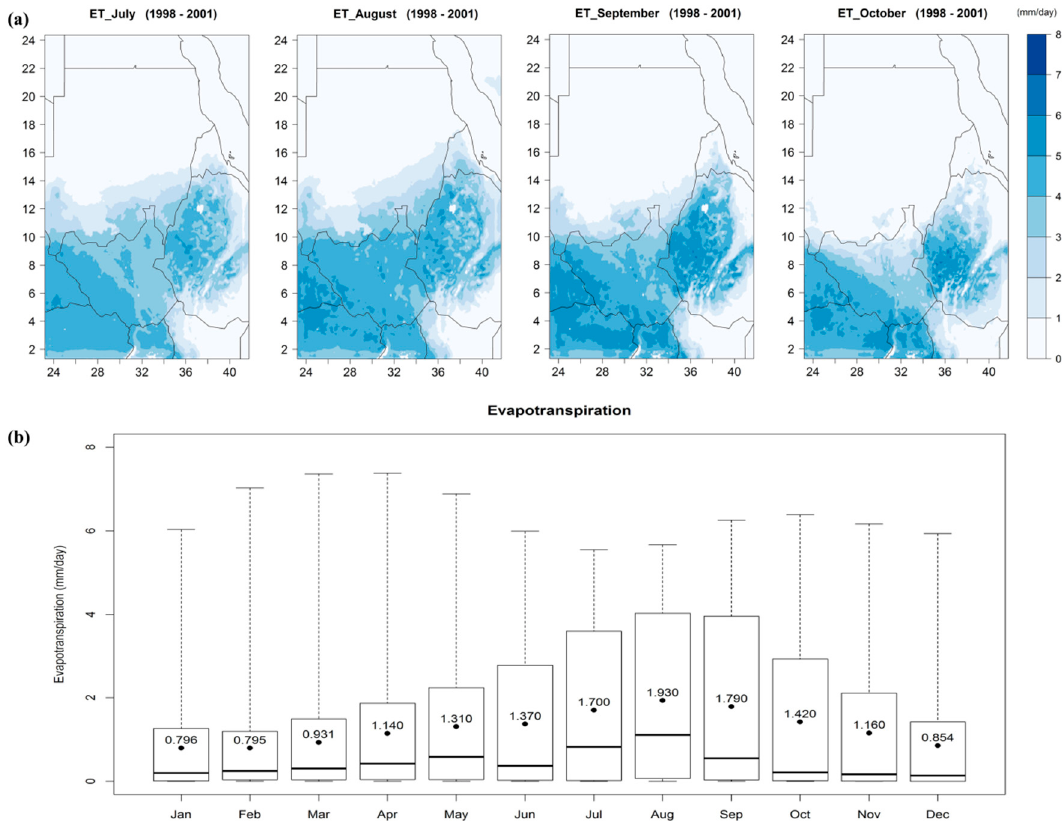
Figure 8. ( a ): average evapotranspiration over the ENB region for the months with the highest mean value, Longitude on the horizontal axis and latitude on the vertical axis. ( b ): boxplots for the evapotranspiration values over the ENB region.